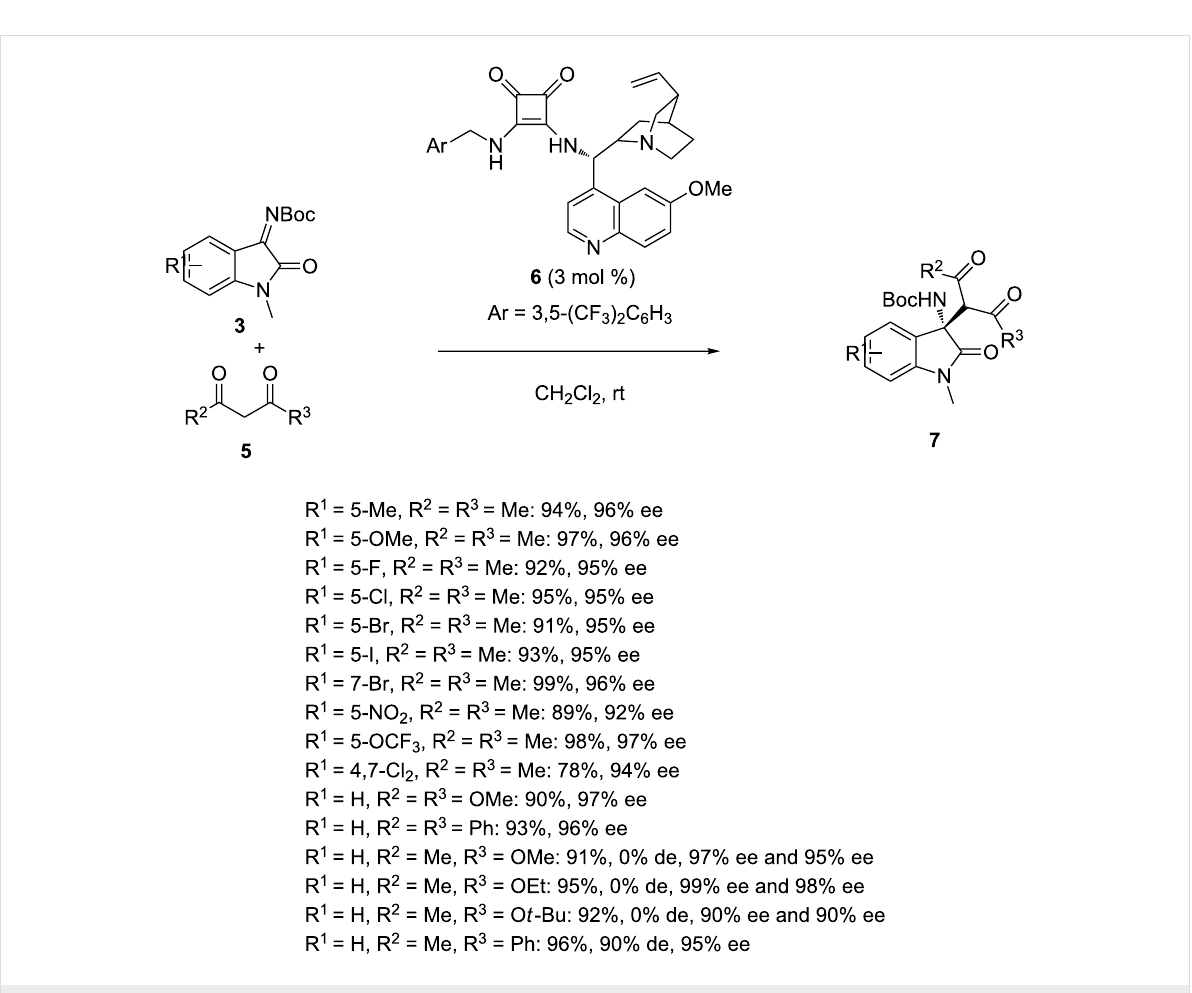
yields (89–99%) and enantioselectivities (92–99% ee). A